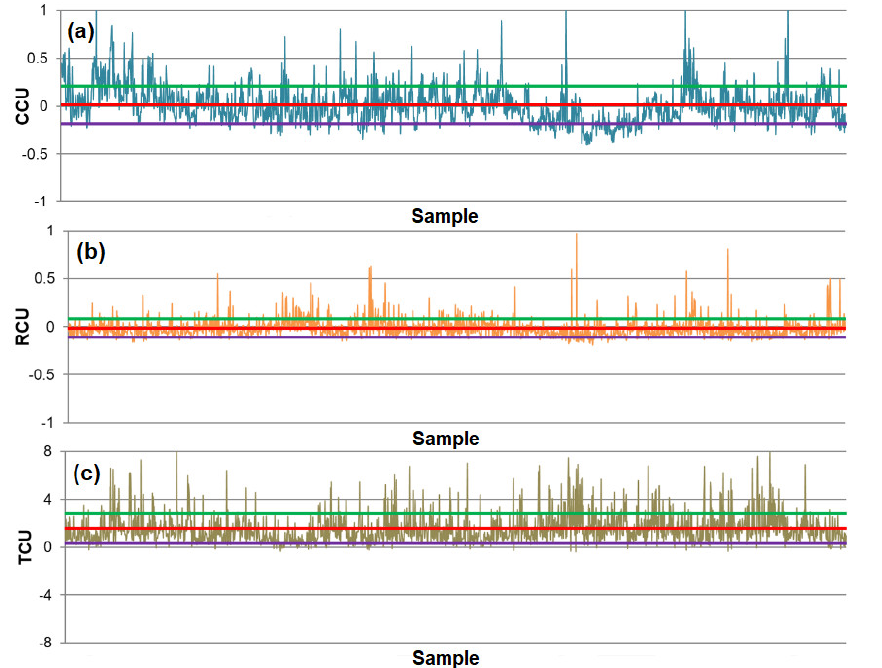
Figure 18. Relative prediction errors of technological indicators according to the PSM model: ( a ) CCU, ( b ) RCU and ( c ) TCU. The red line on the charts represents mean ( µ r ), green line value µ r + 1 SDE r and violet line value µ r − 1 SDE r .